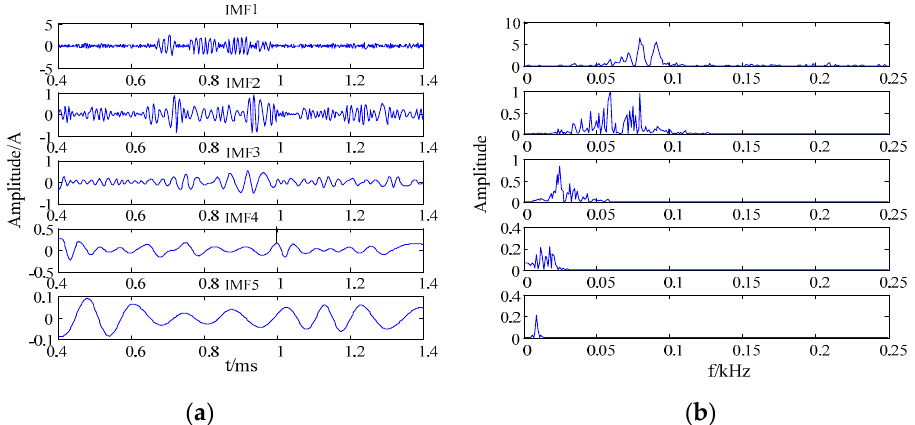
Figure 5. The IMF component and the frequency spectrum of the simulation signal ( a ) the waveform; ( b ) the frequency spectrum.